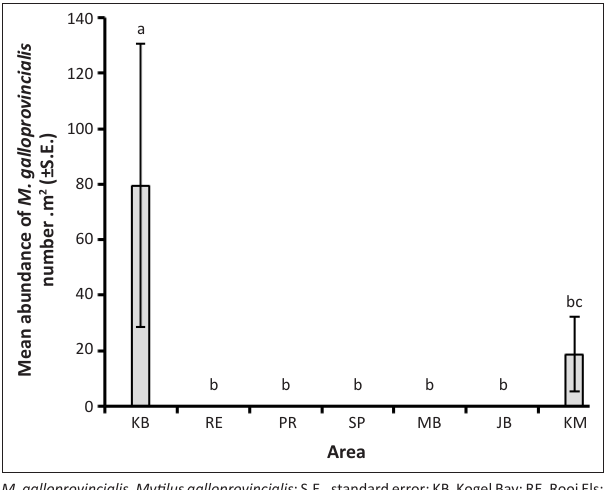
FIGURE 3: Abundance of Mytilus galloprovincialis at the different study